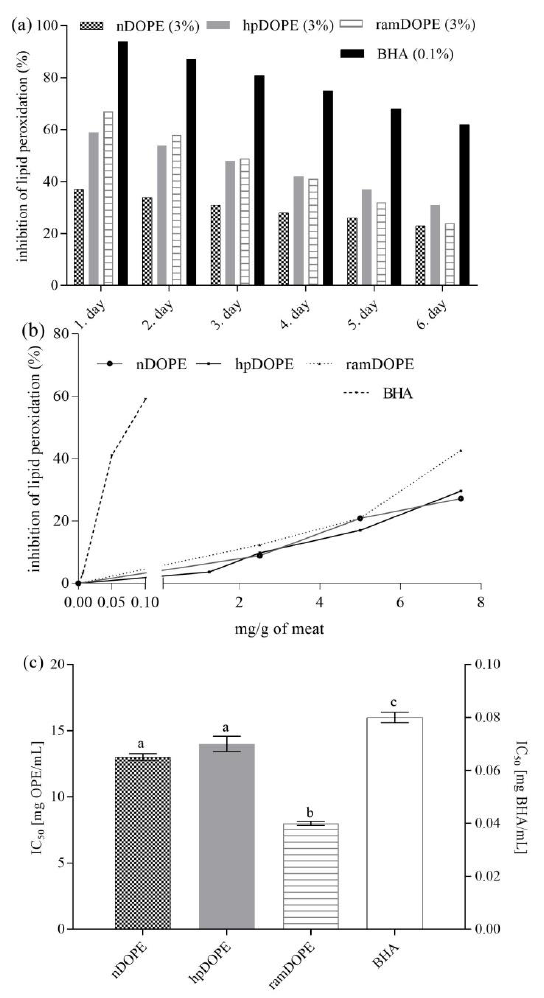
Figure 2. Oxidative stability of minced meat during storage at 4 ◦ C and accelerate stability testing. ( a ): Oxidative stability during storage at 4 ◦ C; ( b ): Inhibition of meat lipid peroxidation during accelerated testing in relation to concentration of antioxidant; ( c ): Antioxidant activity against meat lipid peroxidation during accelerated stability testing expressed as IC 50. nDOPE-native dry olive pomace extract; hpDOPE-extract prepared with hydroxypropyl- β -cyclodextrin; ramDOPE-extract prepared with randomly methylated β -cyclodextrin; BHA: butylhydroxyanisol; IC 50 : Half maximal inhibitory concentration. Different letters above data bars indicate significant difference ( p ≤ 0.05).